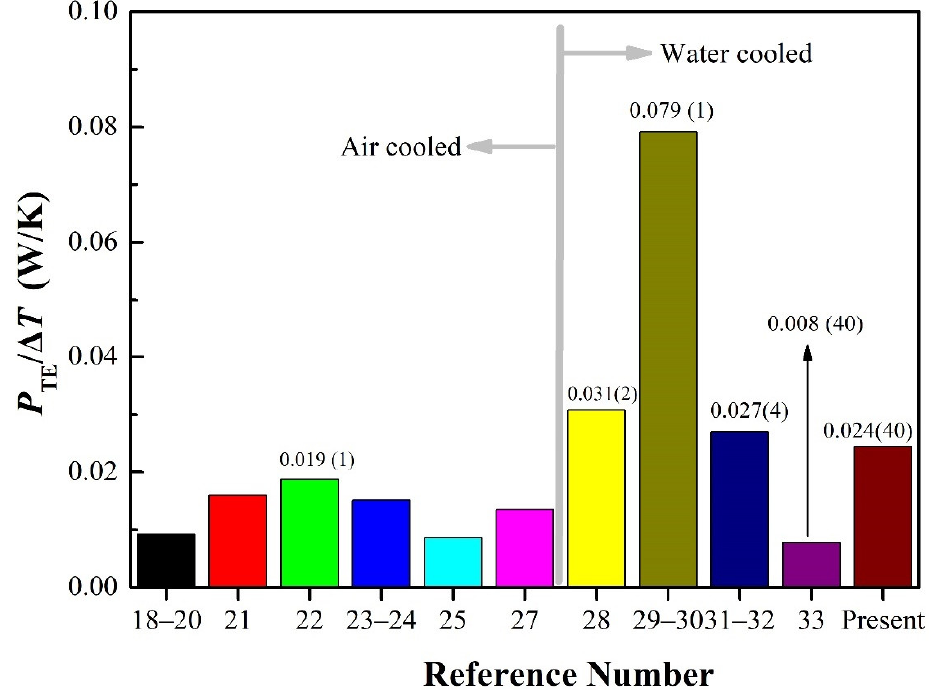
Figure 6. Comparison of P TE / ∆ T with various SPTEGs. The number of TE modules is given inside the parentheses.